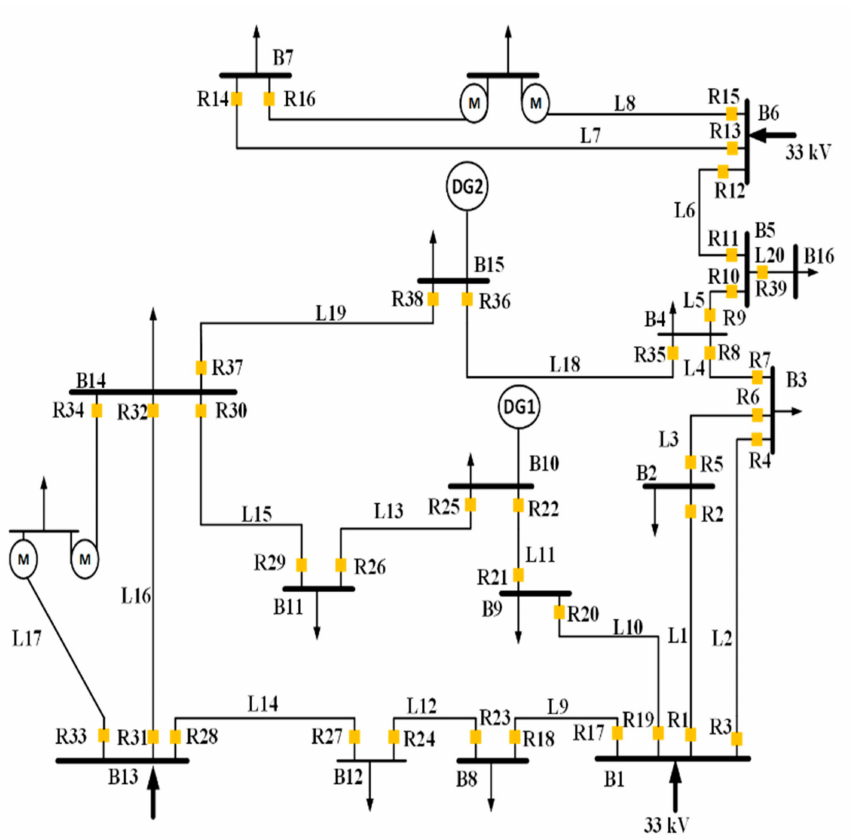
Figure 11. Diagram of the IEEE 30-bus system. Table 16. Primary / backup relay pairs of the IEEE 30-bus